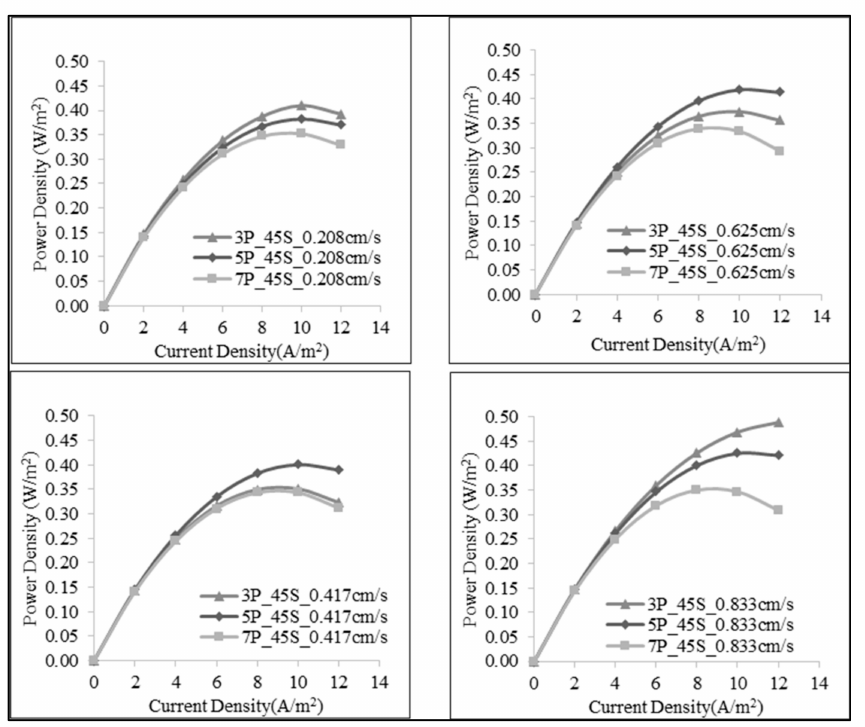
Figure 5. Effect of the number of the membrane pair on power density for the 1:45 salinity ratio. (XP_YS_Zcm/s indicates X membrane pair, Y salt content of HSS and Z feed